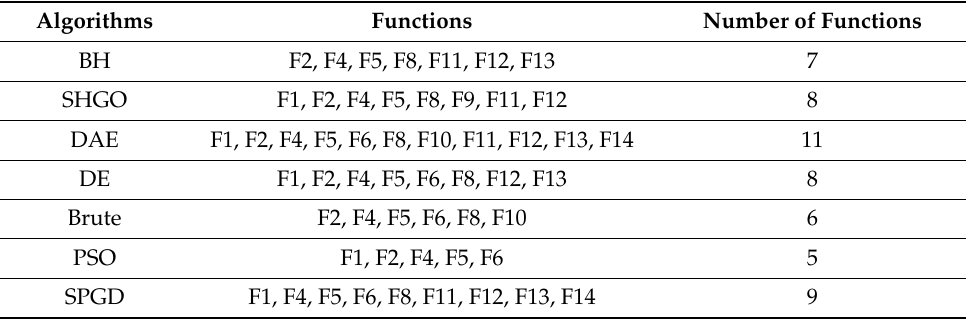
Table 7. The list of test functions for which each algorithm yields an SR greater than